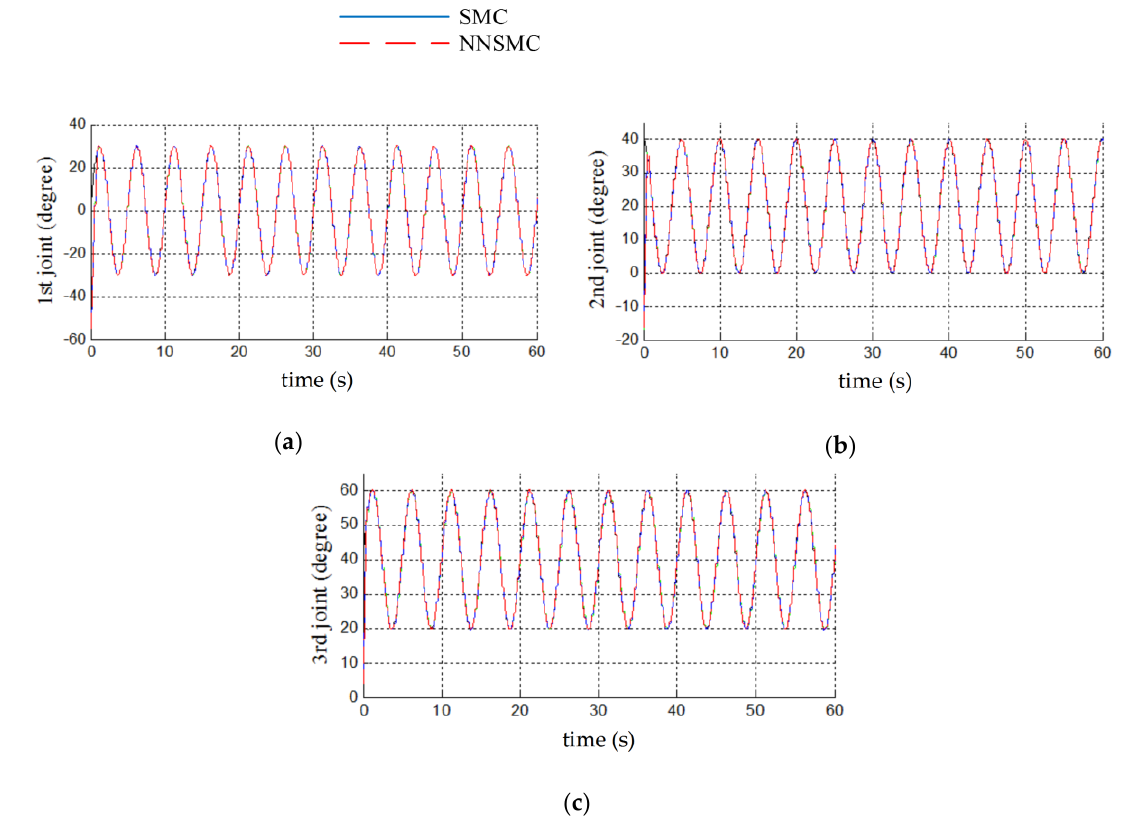
Figure 12. Comparison of the tracking performance of the three joints: ( a ) first joint, ( b ) second joint, ( c ) third joint.